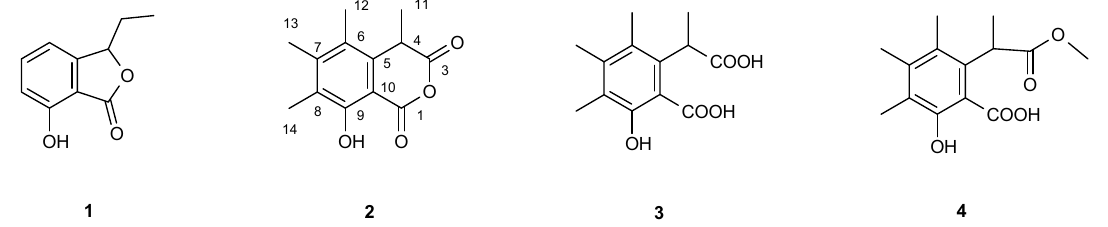
Figure 1. Iso-ochracein ( 1 ), sclerin ( 2 ), sclerin diacid ( 3 ), and its 3-methyl monoester methyl 1-(5-hydroxy-6-carboxylic-2,3,4-trimethylphenyl) propionate ( 4 ) were isolated from the culture broth of Hypoxylon fragiformis . Compounds ( 2 ) and ( 3 ) inhibited the formation of biofilms from the pathogen Staphylococcus aureus but compounds ( 1 ) and ( 4 ) were inactive.